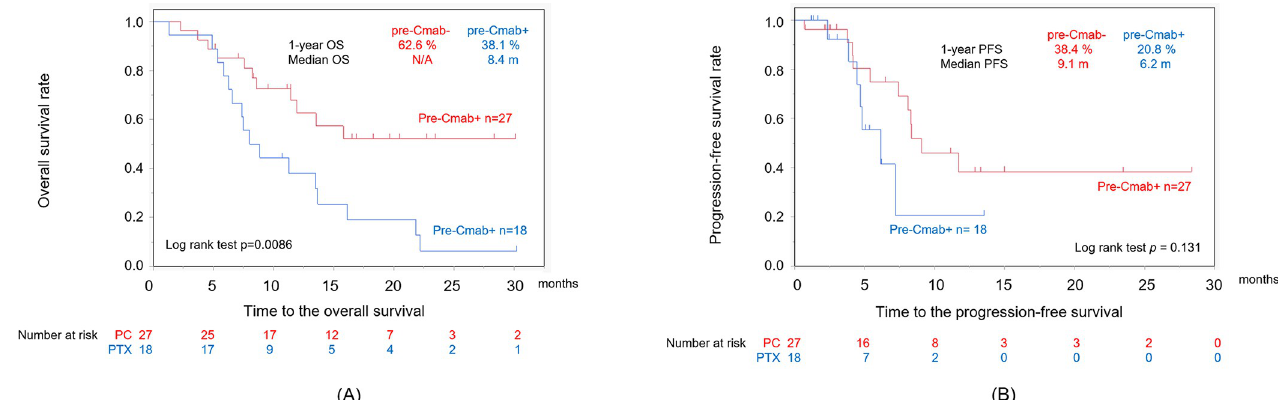
Fig 3. Kaplan–Meier curves for the overall survival (A) and the progression-free survival (B) in R/M HNSCC patients after PTX + Cmab following nivolumab. (A) The overall survival of patients who had received Cmab prior to nivolumab was significantly inferior to that of patients who had not received Cmab before treatment (log-rank test, p = 0.0086). (B) The progression-free survival of patients treated with Cmab before nivolumab was not significantly inferior to that of patients who did not received Cmab before treatment. Cmab, cetuximab; PTX, paclitaxel; R/M HNSCC, recurrent or metastatic head and neck squamous cell